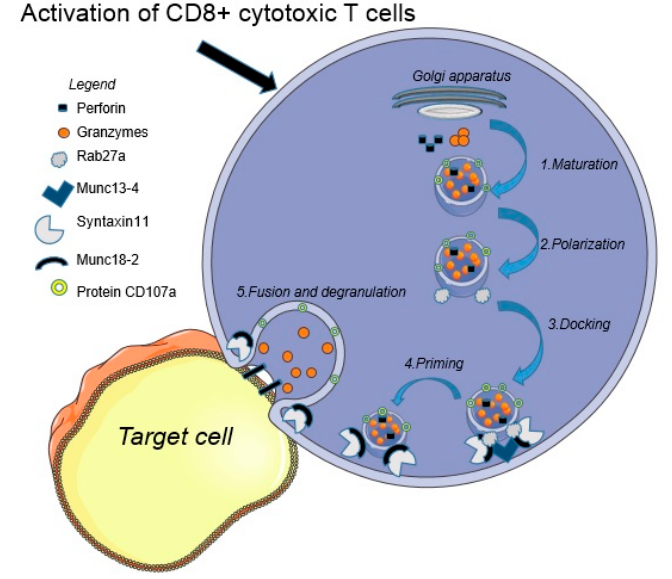
Figure 1. Activation of CD8+ cytotoxic T cells and the pathway of granule and perforin-dependent cytotoxicity. This pathway is formed from the following steps: (1) Maturation: vesicles